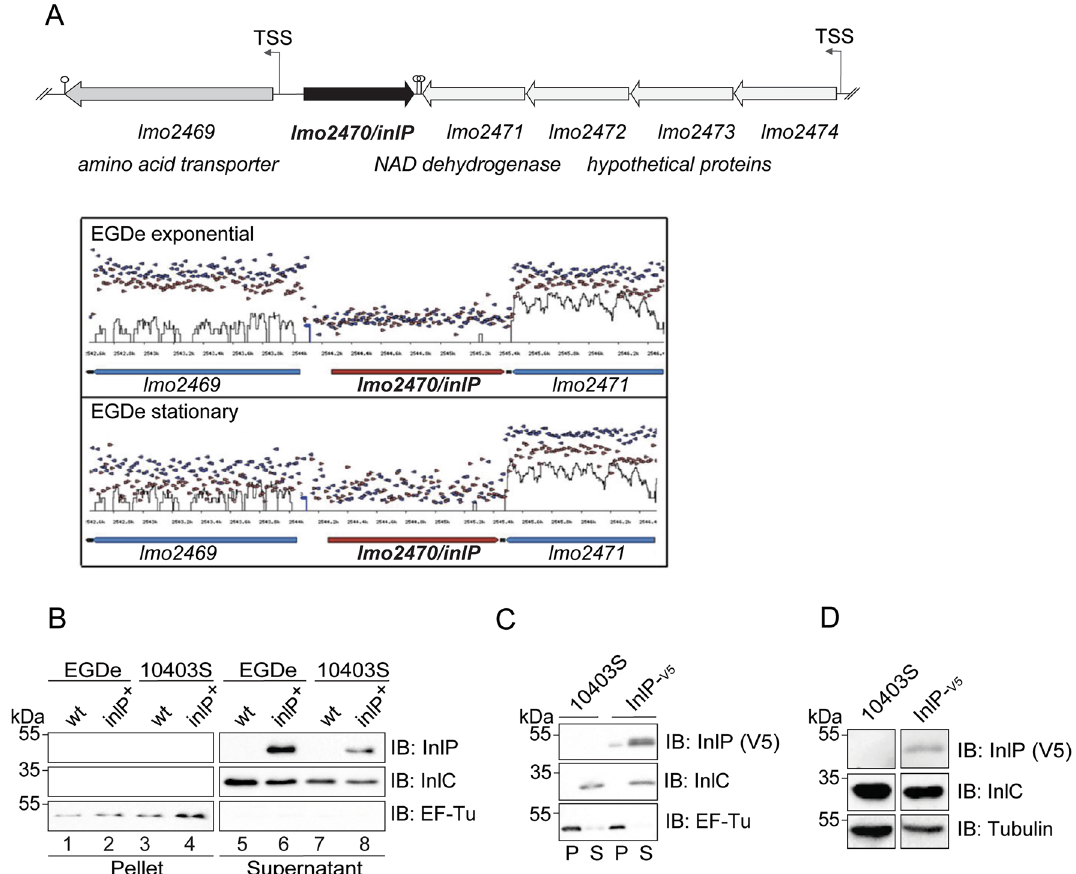
Figure 1. InlP is a secreted protein that is not produced in vitro. ( A ) Genomic organization of the inlP - containing genomic locus in L. monocytogenes EGDe . Arrows and stem and circle represent the transcriptional start sites (TSS) and the transcriptional terminators, respectively. Below, the transcriptional tiling maps of this locus in strain EGDe at exponential or stationary phase in BHI medium at 37 °C (generated from RNA-seq data from 37 ). ( B,C ) Analysis of InlP production in bacterial culture pellets and supernatants in wild type EGDe or 10403S strains or in inlP constitutively-expressing strains ( inlP + or InlP-V5). Total bacterial extracts and supernatant precipitates from stationary phase cultures were separated by SDS-PAGE. InlP or InlP-V5 were detected by immunoblotting with an affinity-purified InlP polyclonal antibody (B) or a monoclonal V5 antibody (C), respectively. EF-Tu and InlC antibodies were used to control the pellet (P) and supernatant (S) fractions, respectively. ( B ) Analysis of InlP production in L. monocytogenes EGDe- and 10403S-containing plasmid pP1 (wt) or pP1- inlP (inlP + ) . ( C ) Analysis of InlP production in L. monocytogenes 10403S and 10403S-InlP-V5 strains. ( D ) Analysis of InlP secretion during infection of JEG-3 cells by 10403S-InlP-V5 strain. Cell extracts of JEG-3 cells infected for 8 h were analyzed by immunoblotting with V5 antibody. InlC detection was used as a control for L. monocytogenes infection and tubulin, as a control for the amount of cell stability of InlP could be tightly regulated, possibly by molecular signals that are not fully recapitulated during infection of cultured cells in vitro. InlP ectopically expressed in human cells localizes to the nucleus and alters the shape of splic- ing speckles. In order to understand the function of InlP, while circumventing the problem of its expression, we analyzed its localization in host cells when directly produced by human cells by transfection. We performed the same analysis with Lmo2027, the structural paralog of InlP (65% identity and 77% similarity to InlP 31 ), which can be used as a control for InlP-specific effects. HA-tagged InlP or Lmo2027 were expressed in HeLa cells and their localization was revealed by immunofluorescence using an anti-HA antibody, 24 h post-transfection. Strikingly, microscopy analysis highlighted a strong accumulation of InlP in the nucleus. In contrast, Lmo2027 was more evenly distributed in the cell, localizing both in the nucleus and in the cytoplasm (Fig. 2A). Quantifica- tion by image analysis of the respective proportion of InlP -HA and Lmo2027 -HA in the nucleus versus cytoplasm confirmed that the nuclear InlP signal was significantly higher than that of Lmo2027 (Fig. 2B). Nuclear localiza- tion of InlP -HA was also observed in HEK293-FT and LoVo cells ruling out a cell type related phenotype (Fig. S2). Given the nuclear localization of InlP, we next assessed whether it could affect the spatial distribution of nuclear sub-compartments. The nucleus is organized into distinct chromosomal territories and numerous